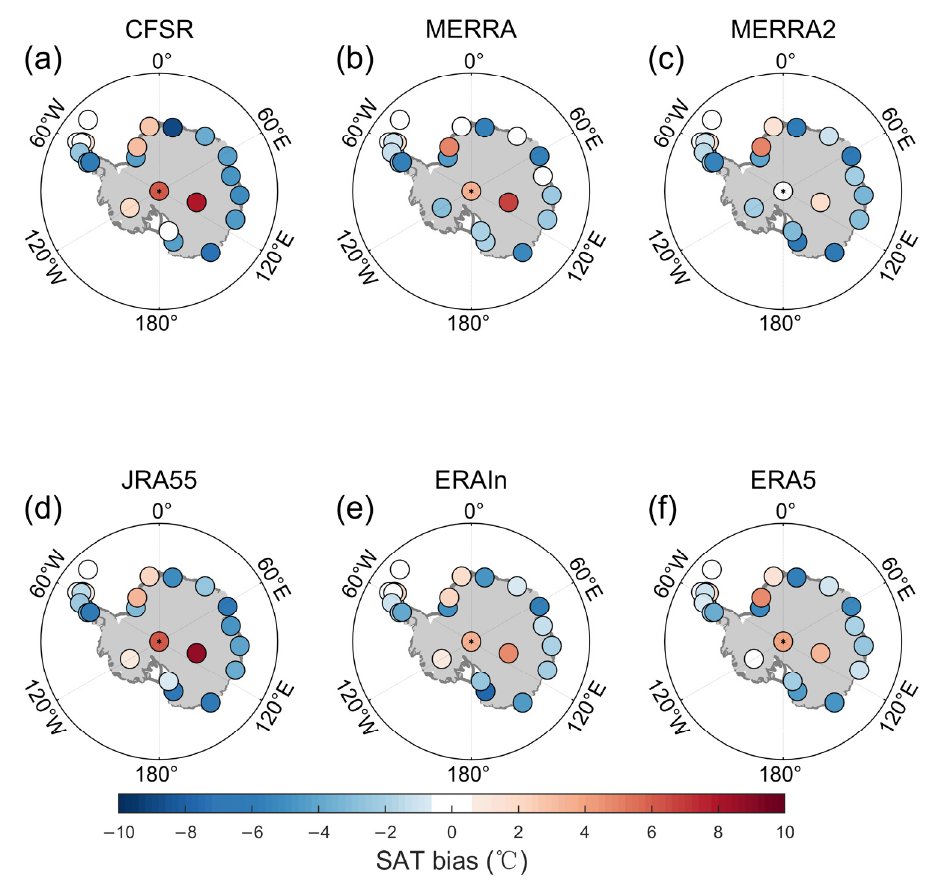
Figure 1. The biases of reanalysis datasets for the Antarctic surface air temperature during 1979–2020. ( a – f ) are for CFSR ( a ), MERRA ( b ), MERRA2 ( c ), JRA55 ( d ), ERA-Interim ( e ) and ERA5 ( f ), respectively.